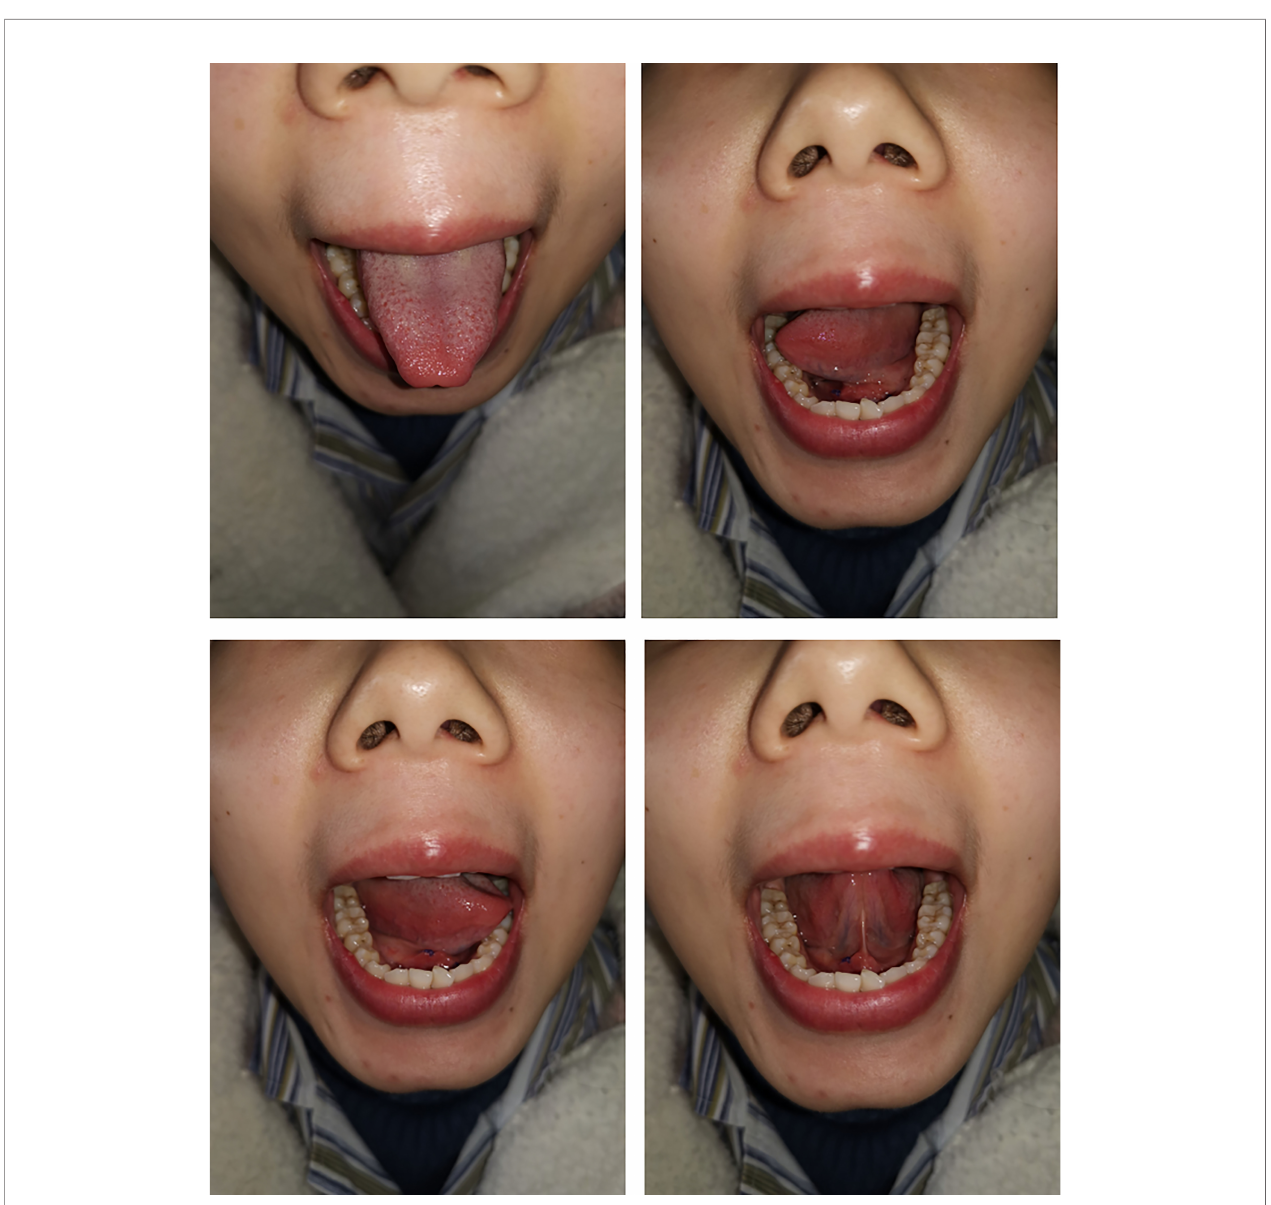
FIGURE 4 | Tongue movement after